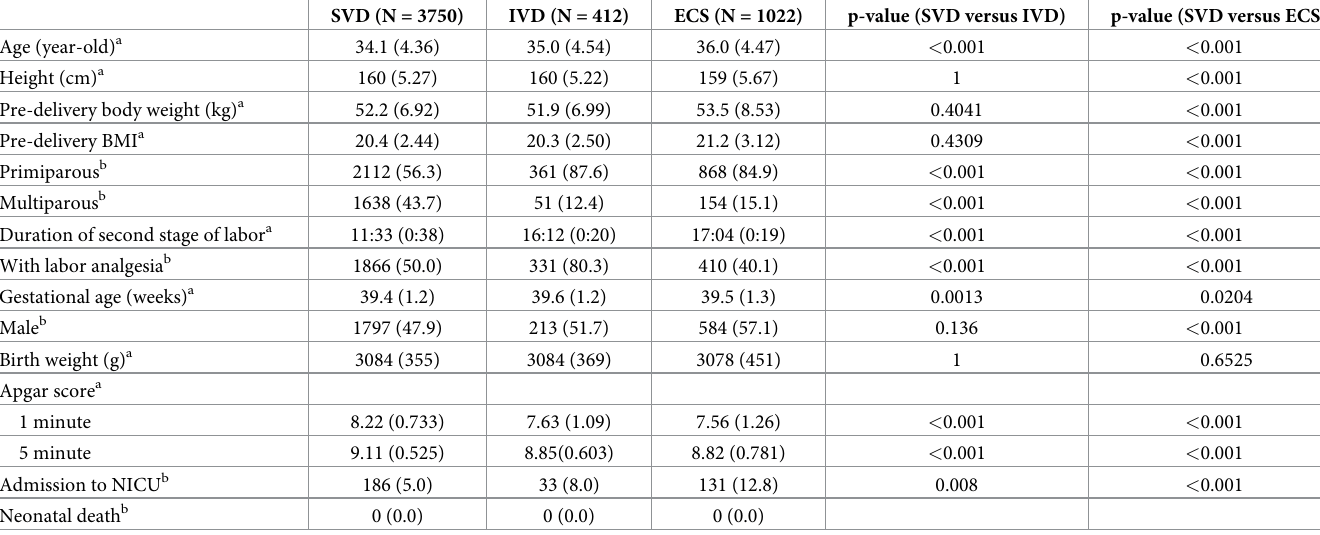
Table 2. Association among mode of delivery at obstetrics inpatients. (N =